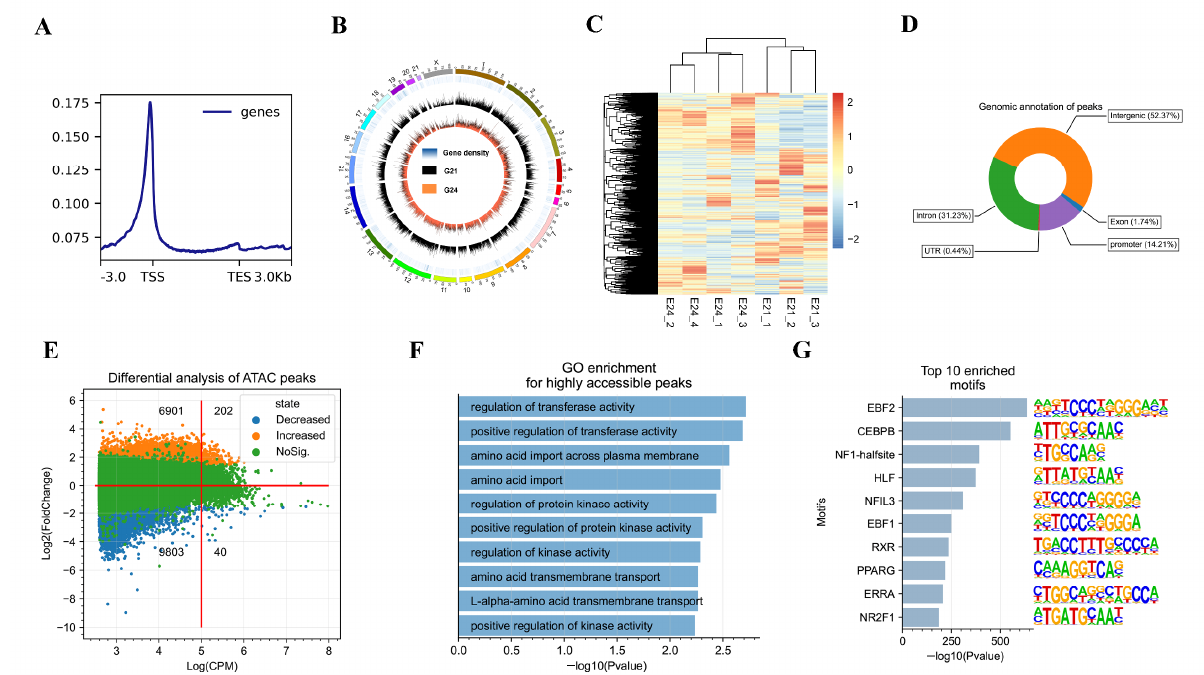
Figure 4. Landscape and changes of chromatin accessibility during the early FBAT development in rabbits. ( A ) The distribution plot of sequencing reads from a representative ATAC-seq library across all genes. ( B ) Genome-wide chromatin accessibility of rabbit FBATs. ( C ) Hierarchical clustering of samples using normalized read counts (CPM values) of genome-wide peaks. ( D ) Genomic annotation of identified ATAC-seq peaks. ( E ) MA plot of differential peaks. The number showed the differential peaks in the corresponding quadrant. ( F ) The top 10 enriched GO-BP terms by the nearby genes of increased highly accessible peaks. ( G ) The top 10 significantly enriched TF binding motifs by increased peaks from G21 to G24 according to the enrichment p -values. The corresponding binding motif of TFs are shown.